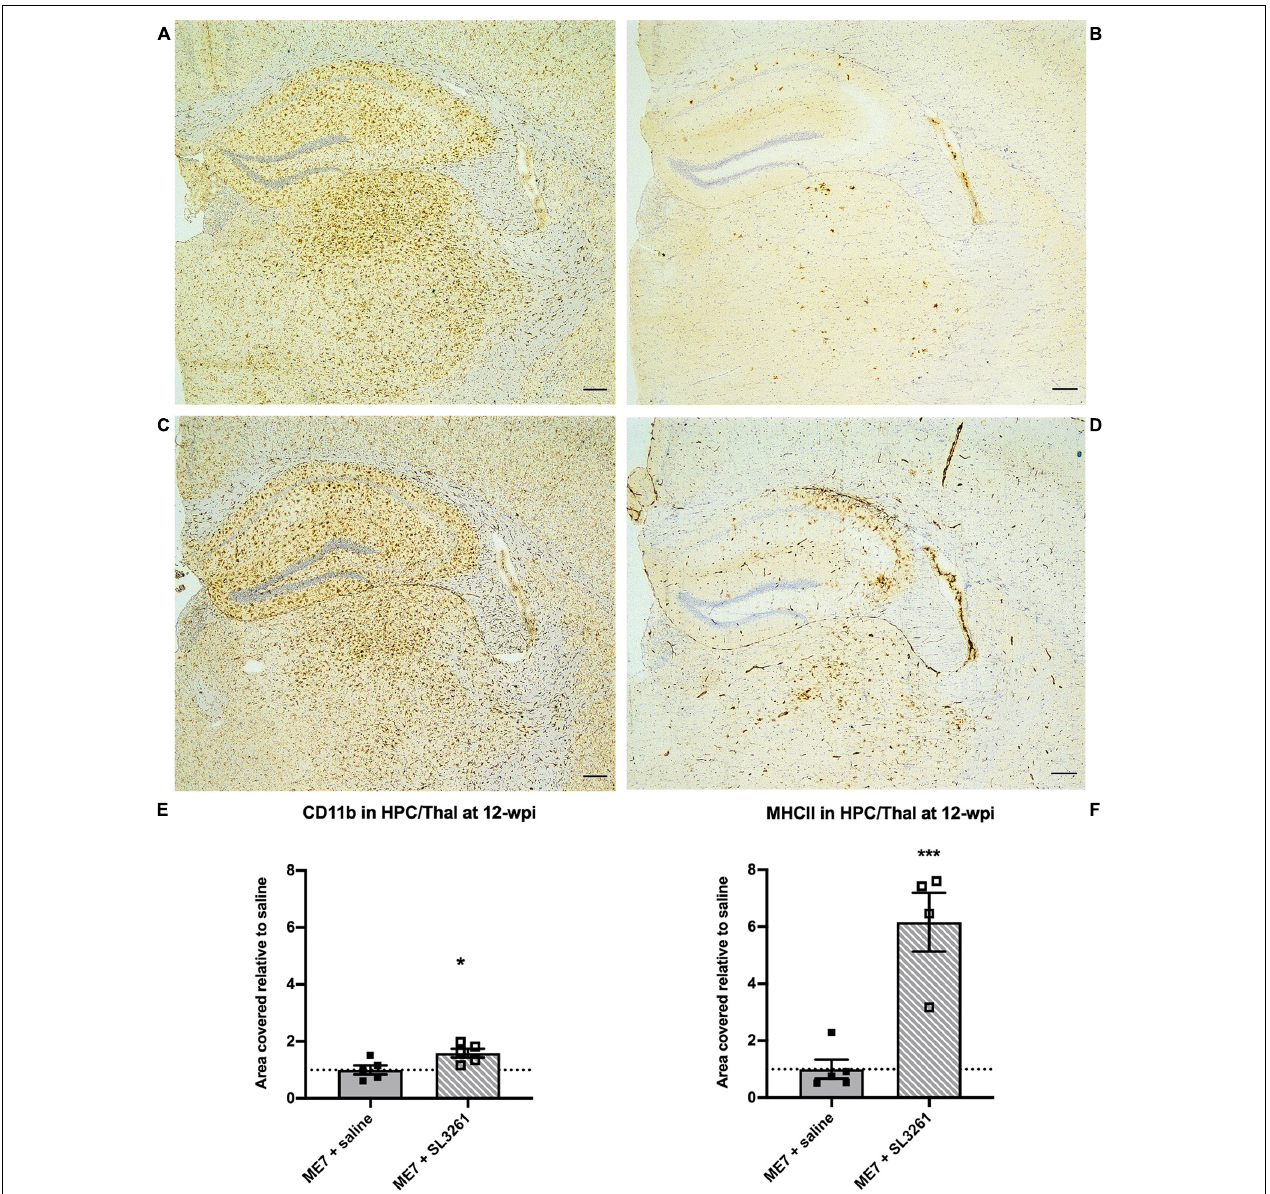
FIGURE 1 | Neuroinflammatory response at early stage ME7 prion disease. Neuroinflammatory response in the hippocampus and thalamus of ME7 prion mice 4 weeks after systemic injection of saline or 1 × 10 6 cfu S. typhimurium SL3261 at 8-wpi. Representative images showing CD11b (A,C) and MHCII (B,D) expression. Scale bar = 200 microns. Quantification of staining shows increased expression after systemic infection with S. typhimurium compared to saline injection for CD11b (E) and MHCII (F) . * p < 0.05; *** p < 0.001 vs. ME7 + saline using one-tailed unpaired Students’ t -test on log-transformed values; n =